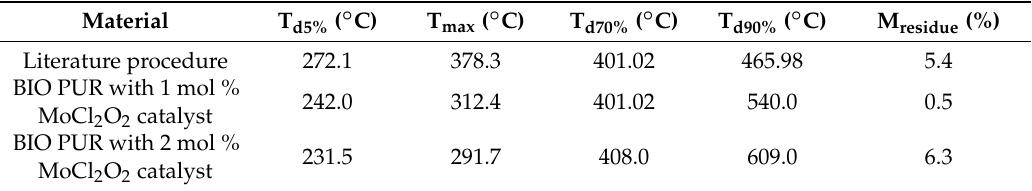
Table 2. The thermal properties of the polyurethane samples.